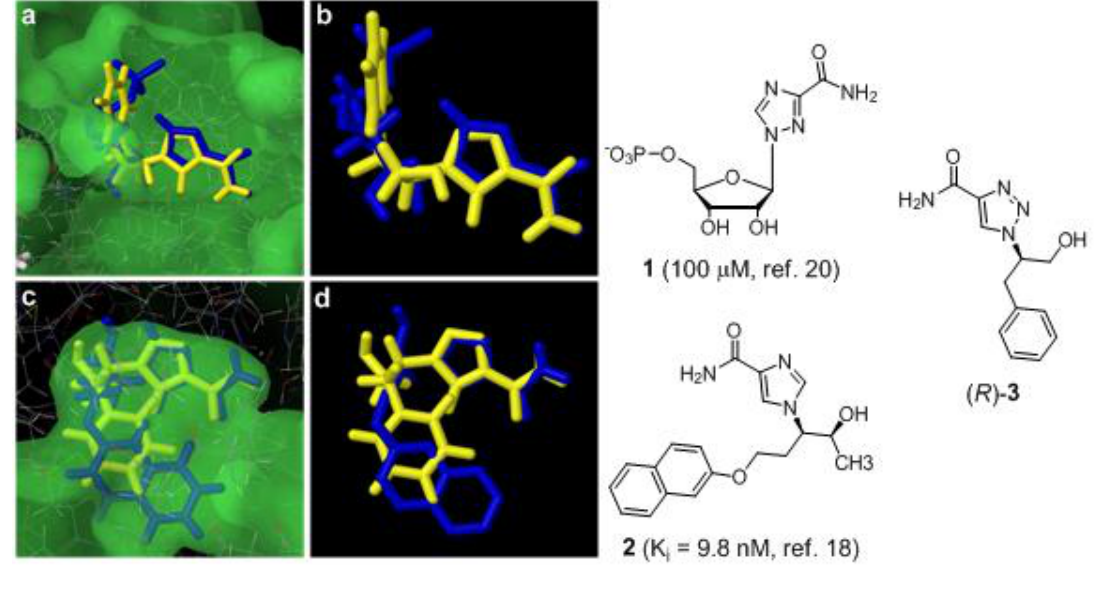
Figure 1. (a) Docked binding mode of ( R ) -3 (yellow) compared to X-ray structure (1R6A) of ribavirin-5’-triphosphate (blue) 1 in the active site of the NS5MTase virus; ( b ) The docking shows that the NH2-groups of compound (R)- 3 and ribavirin-5’- monophosphate are almost superimposed and makes the same important interaction with the carbonyl functions of Leu17 and Leu20 in the protein; ( c ) Docked binding mode of ( R ) -3 (yellow) compared to x-ray structure (1v7a) of inhibitor 2 in the active site of the ADA enzyme; ( d ) The imidazole part of compound ( R ) -3 is almost superimposed over compound 2 and the phenyl ring points in ( R ) -3 in the same direction as the naphtyl ring in 2